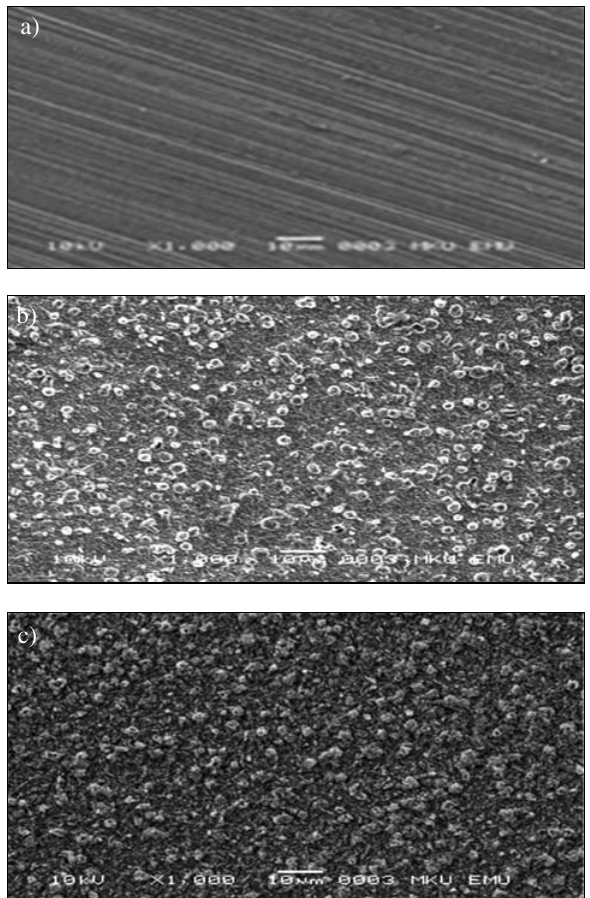
Fig. 2. SEM images of bare CS (a), CS/ZnNi (b) and CS/Zn- Ni/PNMP (c)